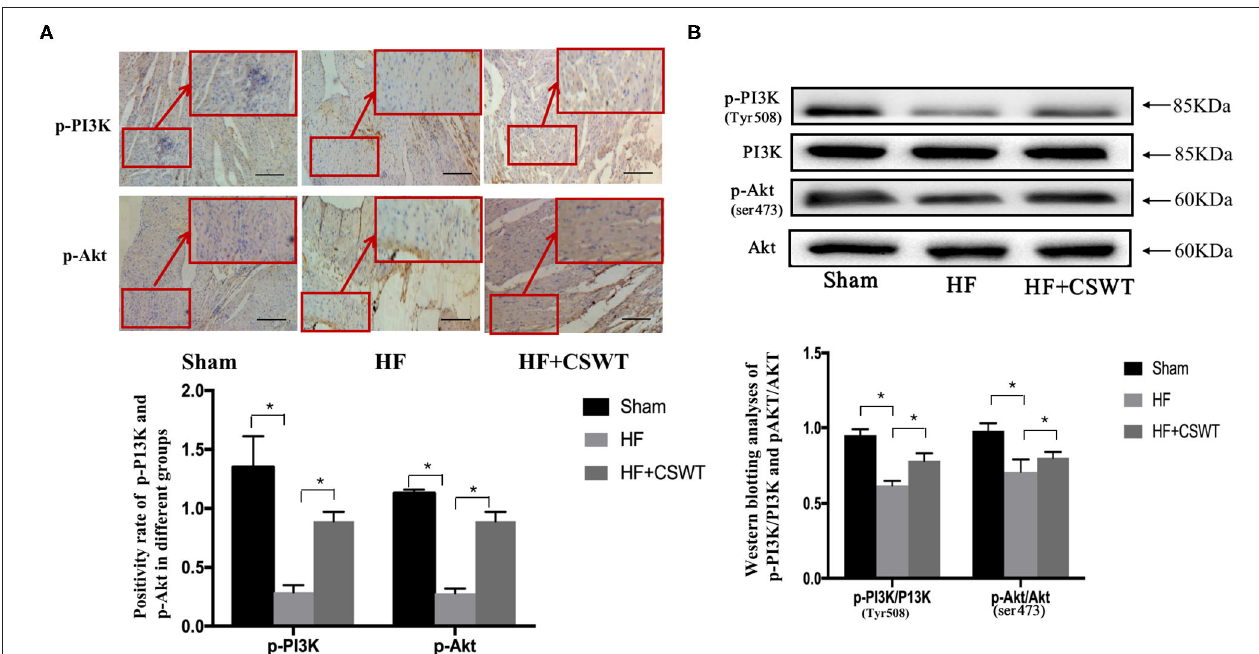
FIGURE 2 | CSWT led to increased PI3K/AKT expression levels. (A) The positive rates of p-P13K and p-Akt in cardiocytes of rats in study group using Immunochemistry analyses; scale bar, 100 µ m; (B) Relative protein expressions of PI3K, Akt, p-PI3K and p-Akt in cardiocytes of rats in study group using Western blot analyses. Values are expressed as mean ± S.E.M ( n = 5). One-way ANOVA test was applied for determining the significance of data. * p < 0.05. CSWT, cardiac shock wave therapy; AMI, acute myocardial infarction; HF, heart failure; S.E.M, standard error of means.